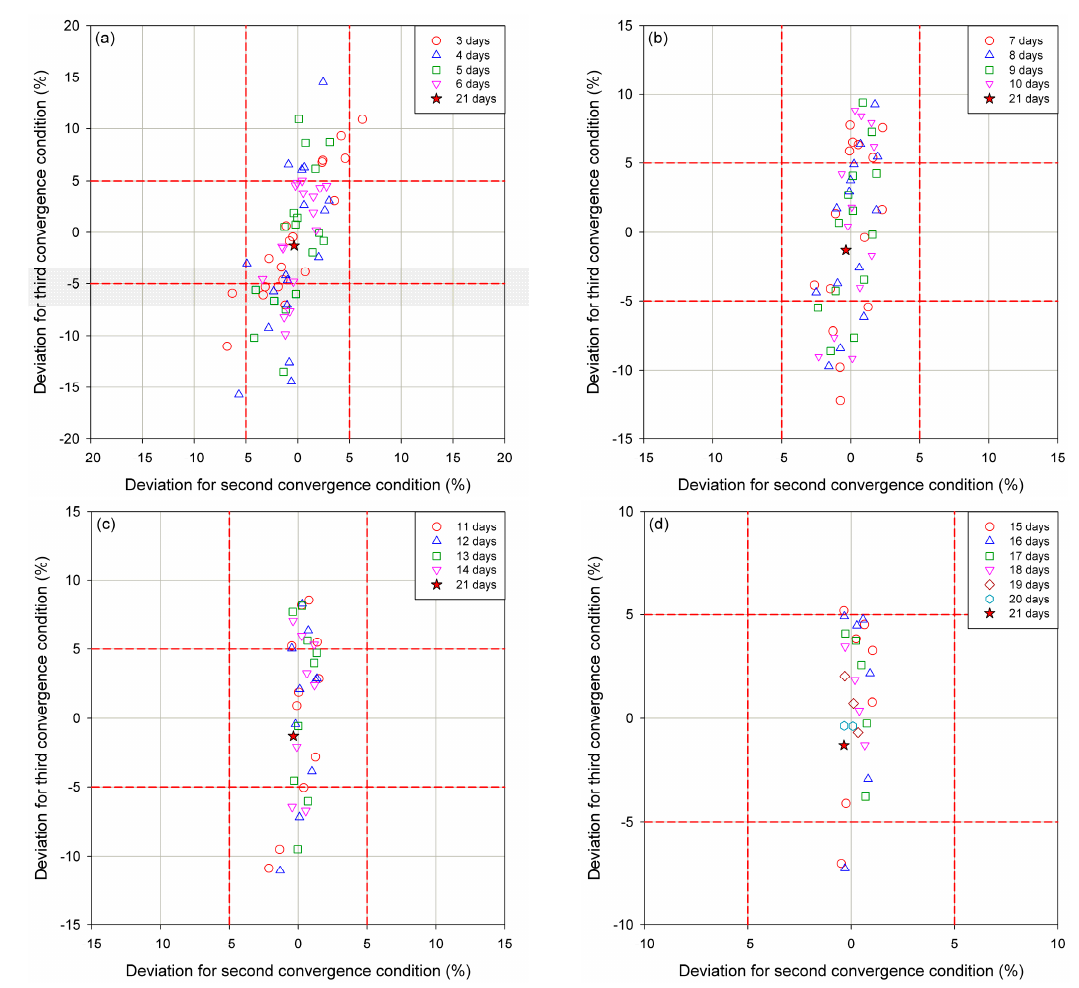
Figure 6. Convergence characteristics of R -values evaluated for different analysis periods according to conditions of the ISO 9869-1 standard. For ease of understanding, the plots are divided into four sub-figures based on the length of the analysis period: ( a ) 3–6 days; ( b ) 7–10 days; ( c ) 11–14 days; ( d ) 15–20 days.